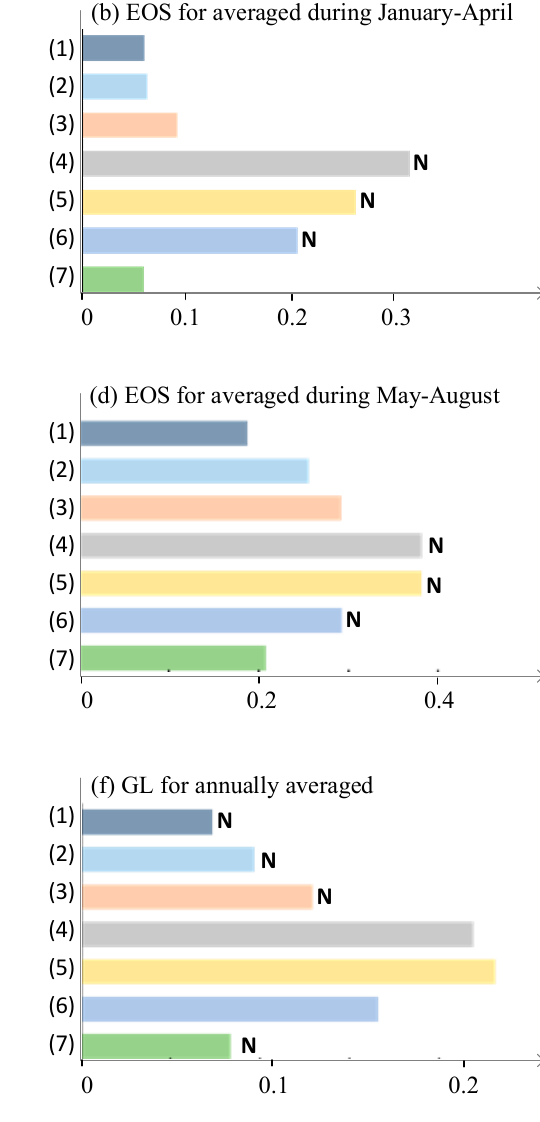
Figure 7. Correlation coefficient between the environmental variables, at different time intervals, and the phenological events in the deciduous forests. The x-axle indicates the correlation coefficient between the phenological event given in the sub-title and a variable, where the label N for the variable indicates a negative correlation. Updated versions means different time intervals, including time windows from January to April, from May to August, and whole year (annual), for (1) SSR, (2) SM, (3) VPD, (4) AAT, (5) MAXT, (6) MINT and (7) PREC.